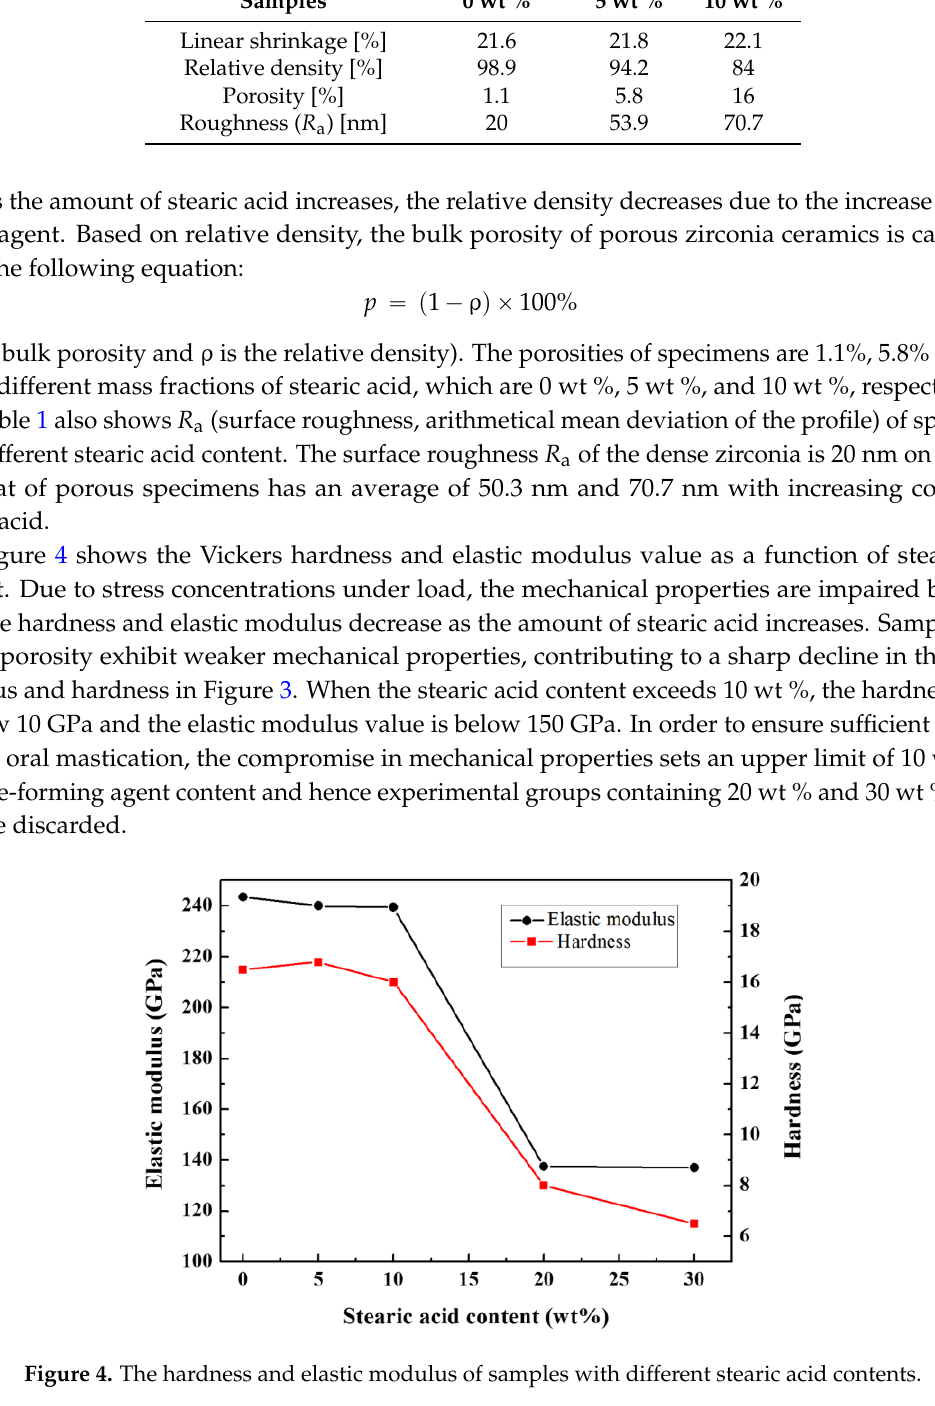
Table 1. The linear shrinkage, relative density, and porosity of samples.